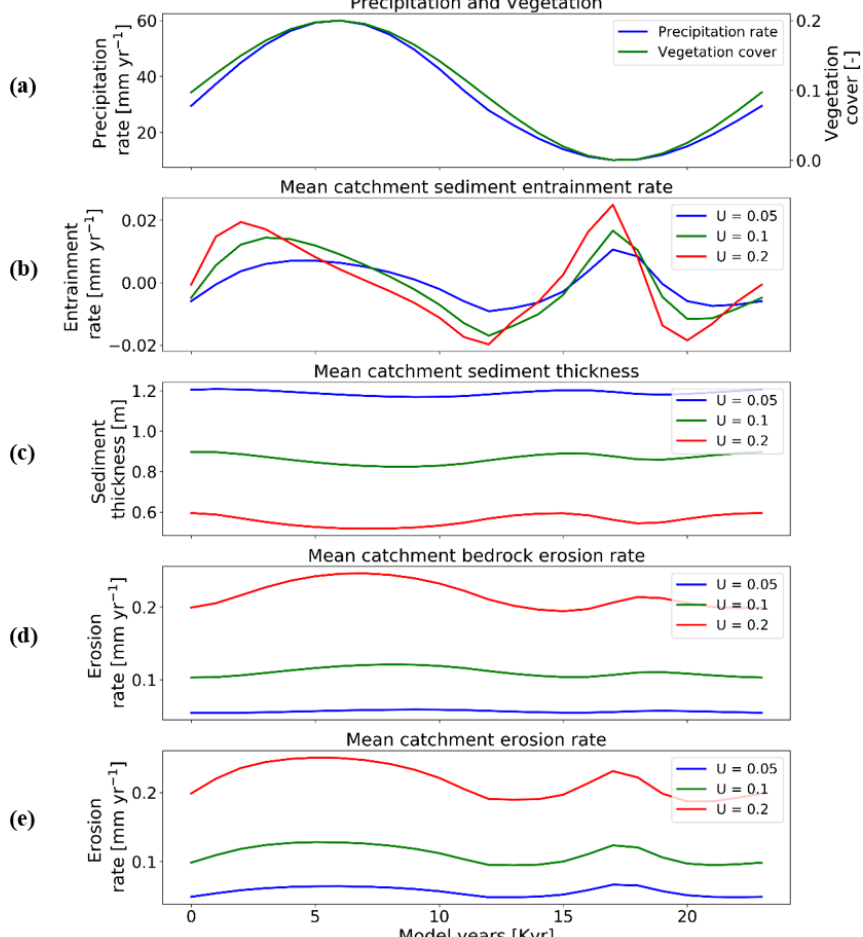
Figure 10. Temporal evolution of catchment-averaged predictions for scenario 5 described in the text (Sect. 3.5). Graphical representation of mean catchment sedimentation and erosion with different rates of rock uplift [mma − 1 ] to (a) coupled oscillations in precipitation [mmyr − 1 ] and vegetation cover [–] in terms of (b) sediment entrainment [mmyr − 1 ], (c) sediment thickness [m], (d) bedrock erosion [mmyr − 1 ], and (e) mean erosion rates [mmyr − 1 ] for the entire catchment. The periodicity of climate and vegetation oscillations is 23kyr. The simulations represent 10% initial vegetation